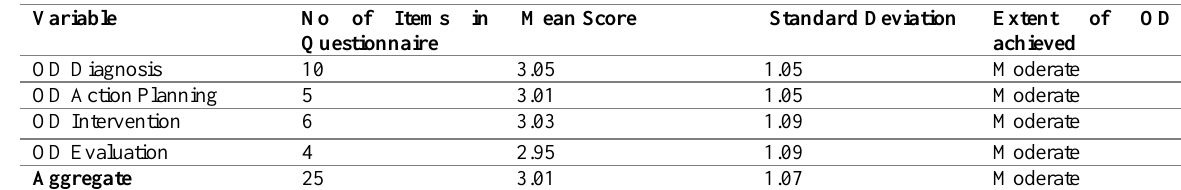
Table 2: Extent of Organization development intervention